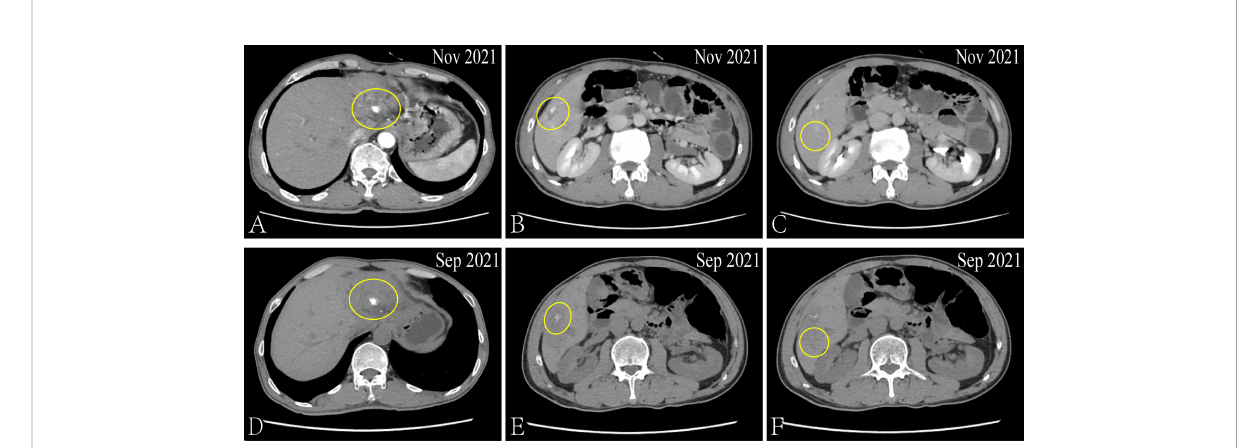
FIGURE 4 Via CT to contrast the curative effect between the Nov 2021 and Sep 2021. The size of the metastatic lesion which in the left and caudate lobe of liver is reduction from 3.3 × 2.6cm to 2.8 × 2.2cm (A, D) . The size of the metastatic lesion which in liver S5 is reduction from 2.3 × 1.1cm to 2.0 × 0.9cm (B, E) . The metastatic lesion in liver S6 has disappeared (C, F)